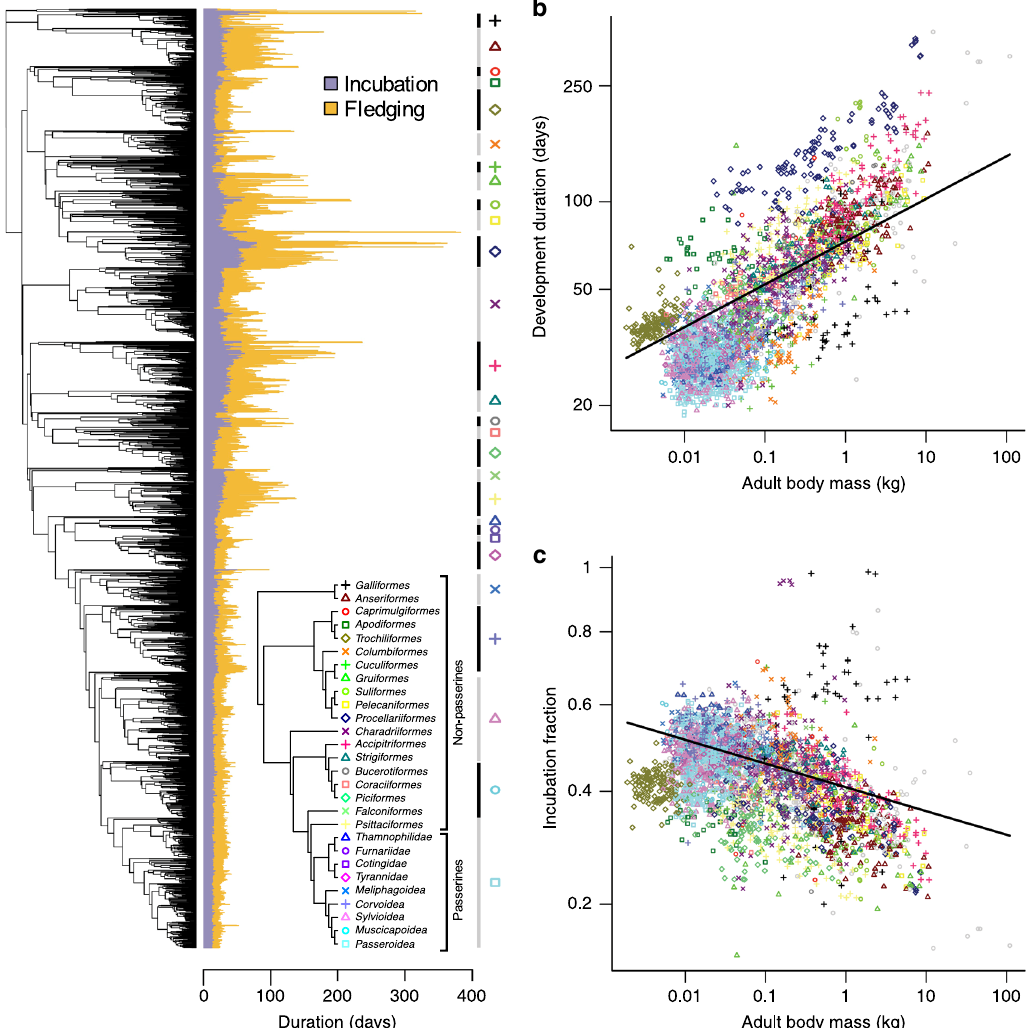
Fig. 2 The diversity, phylogenetic distribution and allometry of development periods in birds. a The phylogenetic distribution of incubation, fl edging and total development (incubation + fl edging) period across 3096 species of birds. Inset tree schematic indicates the relationships among major taxonomic groups (>20 spp.) and provides a key for the plotting symbols used throughout the fi gure. b , c Allometric relationships of (log-transformed) development period length ( b ) and (square root-transformed) incubation fraction ( c ) with (log-transformed) adult body mass. Lines indicate the regression slopes estimated by phylogenetic regression. Source data are provided as a Source Data fi